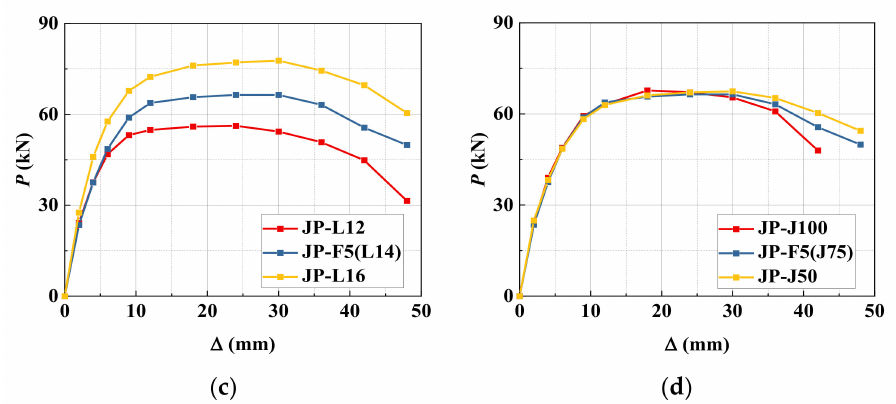
Figure 31. Skeleton curves. ( a ) The number of freeze–thaw cycles. ( b ) The ratio of axial compression. ( c ) Diameter of longitudinal reinforcement. ( d ) Stirrup spacing.